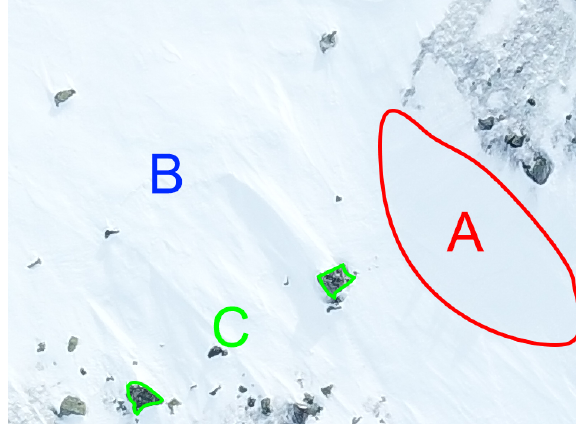
Figure 2. Cropped image from the use case presented in section 4. A is an area that is shaded by the relief to the top right, and therefore has absolutely no texture, while B is well lit from an angle and the micro-topography is highlighted. The C areas are example of stable terrain that protrude over the snow, and can be used for the corrections presented hereafter.